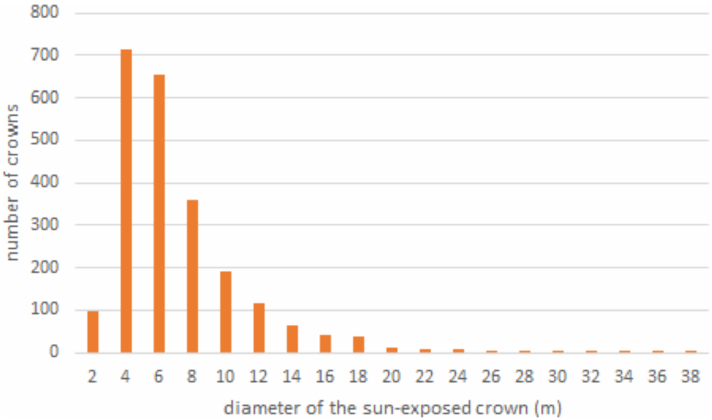
Figure A2. Distribution of tree crown sizes on BCI in a sample ∼ 10ha plot taken from digitized high-spatial-resolution stereophotos that were linked to stems in the field (Bohlman and Pacala 2012). This ∼ 10ha plot does not coincide with the ∼ 10ha area sampled by the UAS near the eddy covariance tower in this